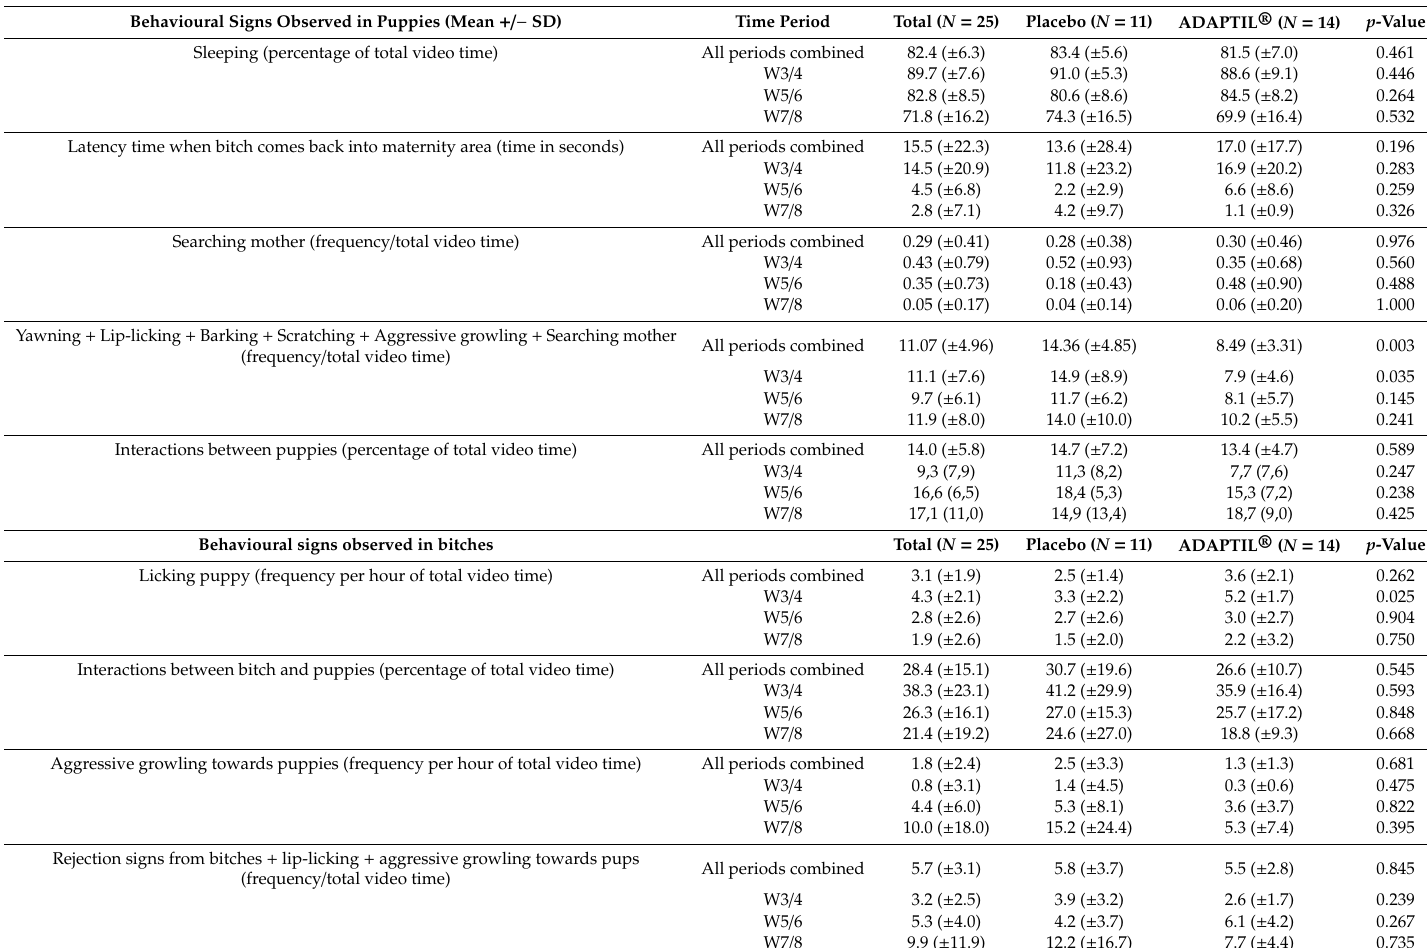
Table 6. Behavioural signs observed in puppies and bitches through video recording throughout the weaning period at each time point and during the full weaning